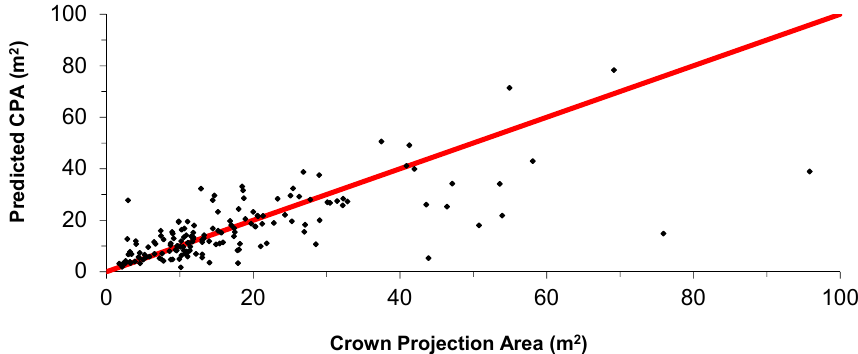
Figure 6. Predicted versus measured values of Crown Projection Area (CPA). The red line indicates 1:1 ratio.